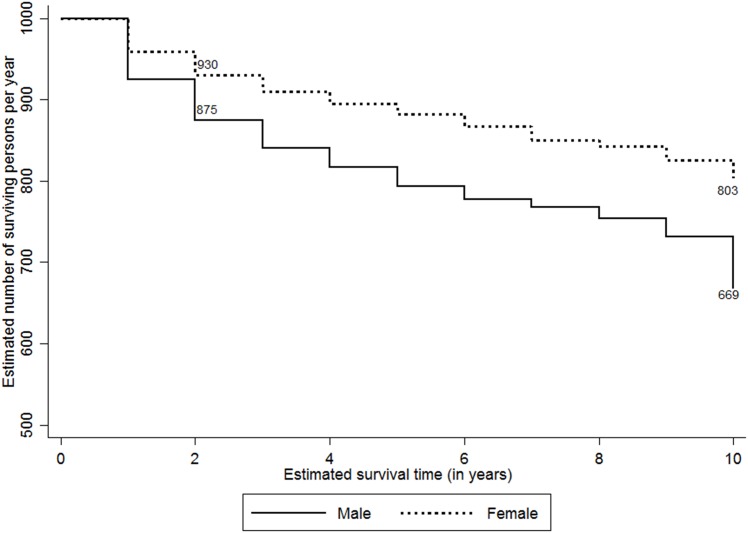
Adjusted Kaplan-Meier survival estimates by sex (per 1000 persons per year).The line graph shows ten-year survival probability curves among PLHIV per 1000 persons per year since they tested positive for HIV by sex of the PLHIV. The estimates are adjusted by their place of residence.